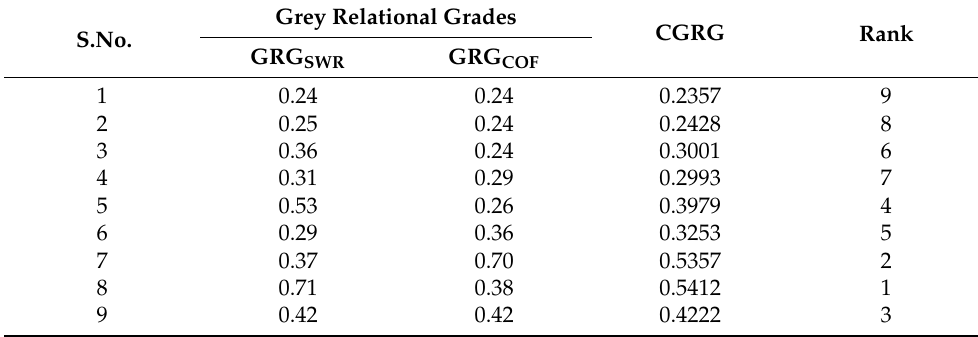
Table 8. Grey relational grades and their